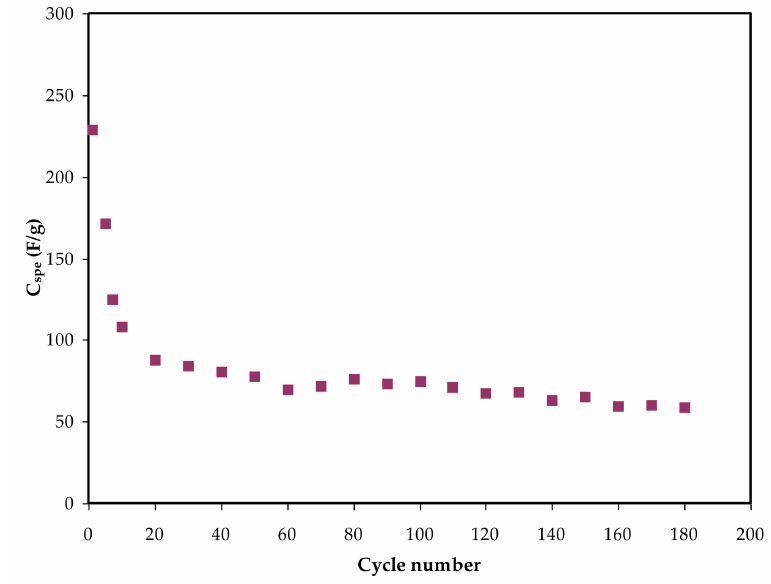
Figure 9. Specific capacitance for the constructed EDLC throughout 180